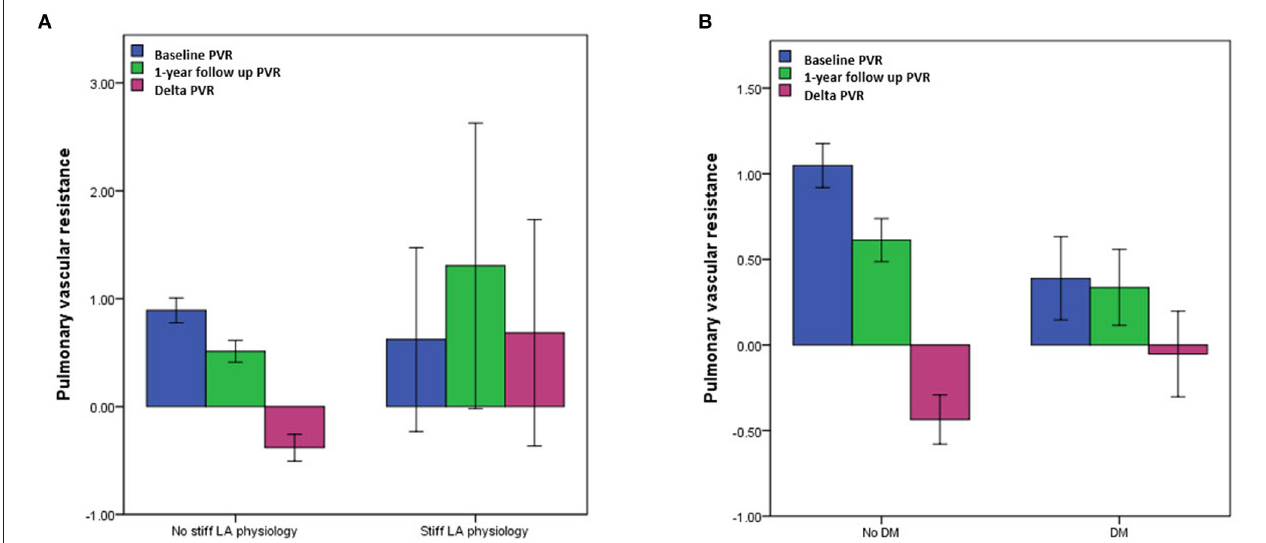
higher in the patients with DM than in those without ( p =